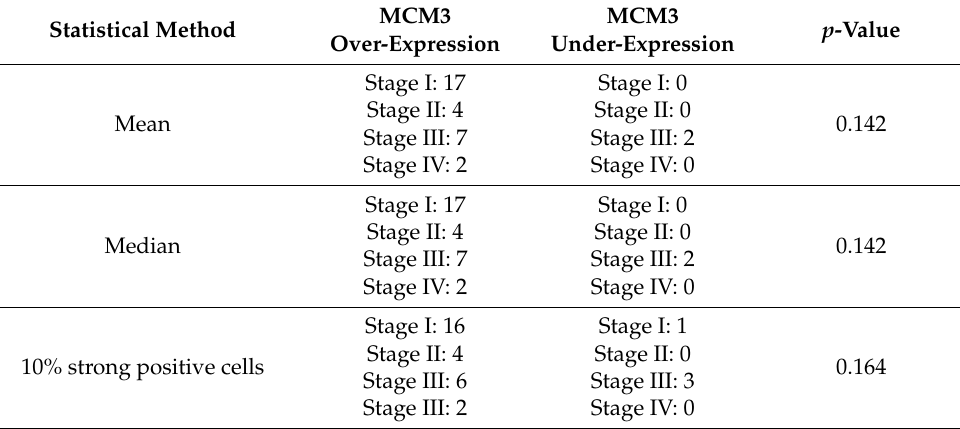
Table 8. MCM3 expression correlation with TNM stage. Statistical